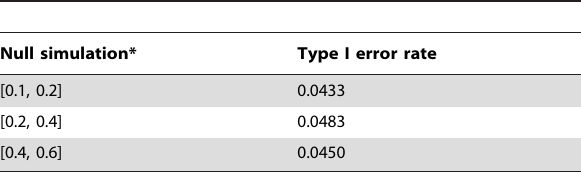
Table 1. Type I error rate for null CNA datasets analyzed by